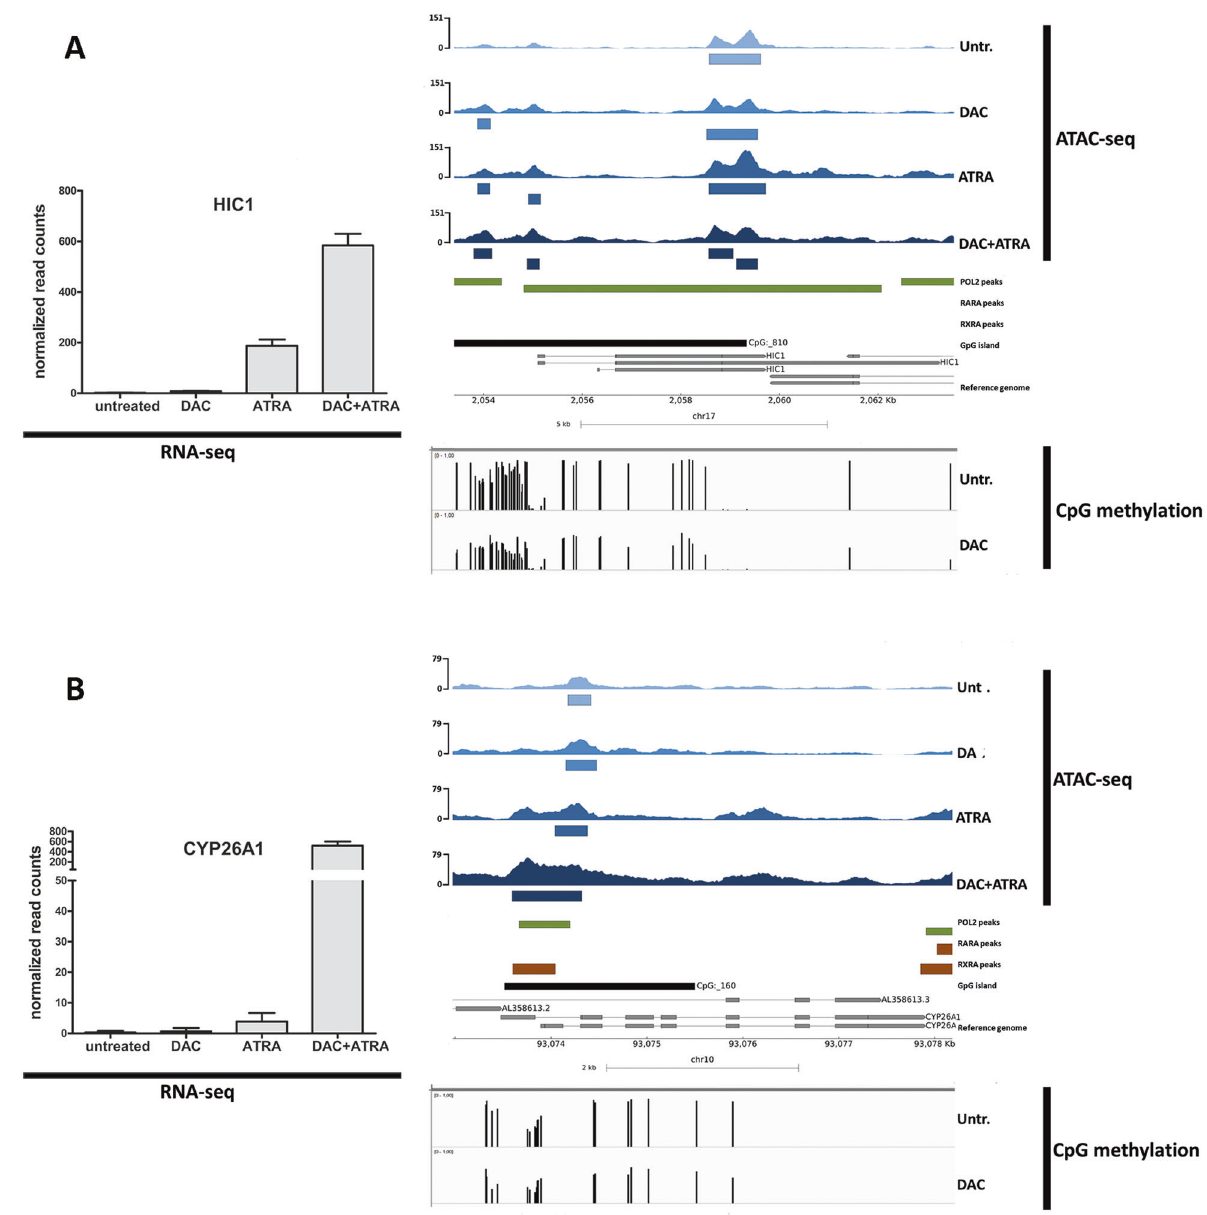
Fig. 4 Transcriptional induction of HIC1 and CYP26A1 by DAC and ATRA is associated with changes in chromatin accessibility. A , B mRNA expression (normalized read-counts) of HIC1 ( A ) and CYP26A1 ( B ) of both untreated U937 cells and U937 after treatment with either DAC, ATRA, or DAC + ATRA at 72 h was determined by RNA-seq (left panel). Chromatin accessibility of these cells and treatment modes was determined by ATAC-seq (upper right panel). Blue boxes below the ATAC-seq track represent signi fi cant effects. Annotations for POLR2A binding sites (green boxes), retinoic acid receptors RARA and RXRA (brown boxes) and CpG islands (black boxes) were extracted from ChiP- seq data accessed from ENCODE and GEO (right panel). CpG methylation data of U937 cells untreated or treated with DAC were determined by In fi nium HumanMethylation450 BeadChip Assay [8] (lower right